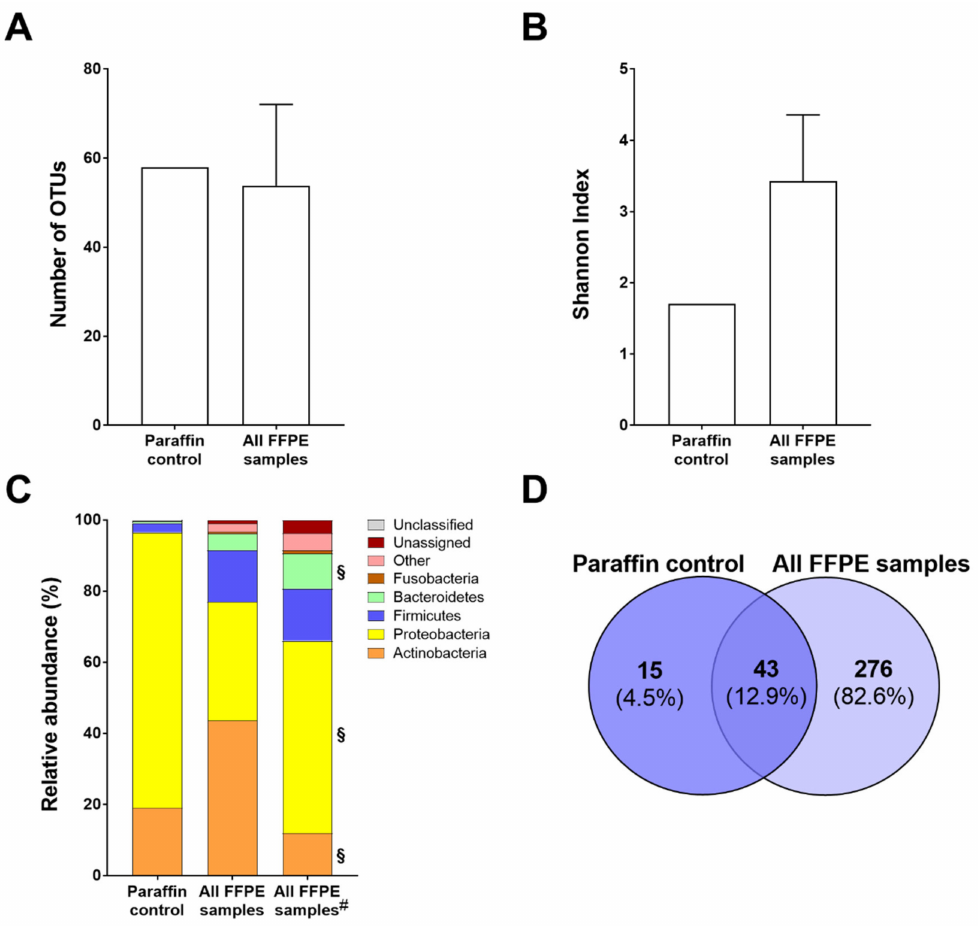
Figure 1. Impact of the embedding of FFPE tissues on the microbiota characterization. ( A ) Number of OTUs of the para ffi n control and all FFPE samples obtained after randomly subsampling to a fixed depth. ( B ) Microbial alpha-diversity assessed by the Shannon index. ( C ) Taxonomic profile at the phylum level discriminating the most abundant phyla in the para ffi n control and all FFPE samples before and after (#) OTU subtraction. § stands for significantly di ff erent from all FFPE samples at p < 0.05. ( D ) Venn diagram showing the number OTUs common and exclusive to the para ffi n control and FFPE